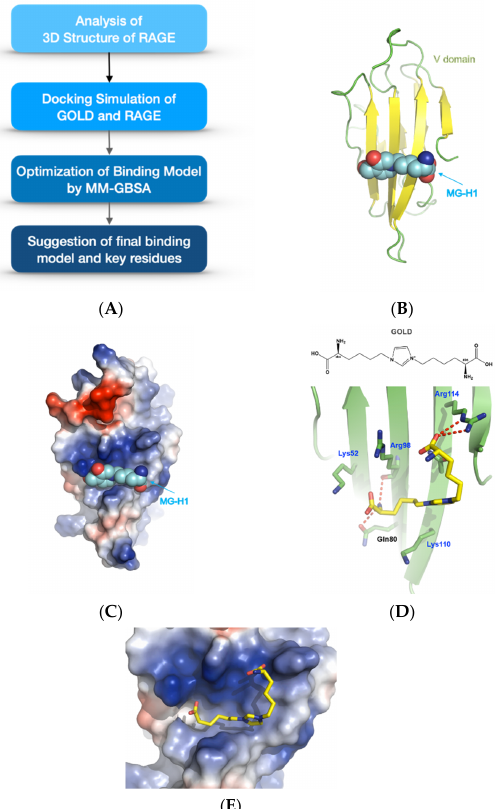
Figure 2. Prediction of the binding model between the glyoxal-lysine dimer (GOLD) and RAGE. Signaling in the mechanisms of GOLD treatment was investigated. Mesangial cells were stimulated with GOLD (500 μM) for 24 h. ( A ) Steps of the docking simulation to determine the binding model of GOLD and RAGE ( B ) Binding structure of the V domain of RAGE and the known ligand methylglyoxal-derived hydroimidazolone-1 (MG-H1) according to nuclear magnetic resonance (NMR) (2MOV.pdb). ( C ) Electrostatic surface model of the V domain of RAGE. ( D ) Binding model of GOLD and the V domain of RAGE according to the docking simulation. The red dashed line represents the H-bond. ( E ) Electrostatic surface model of GOLD and RAGE. Blue indicates the positively charged region, and red indicates the negatively charged region. There are many positively charged residues (colored blue) around the GOLD-binding site.